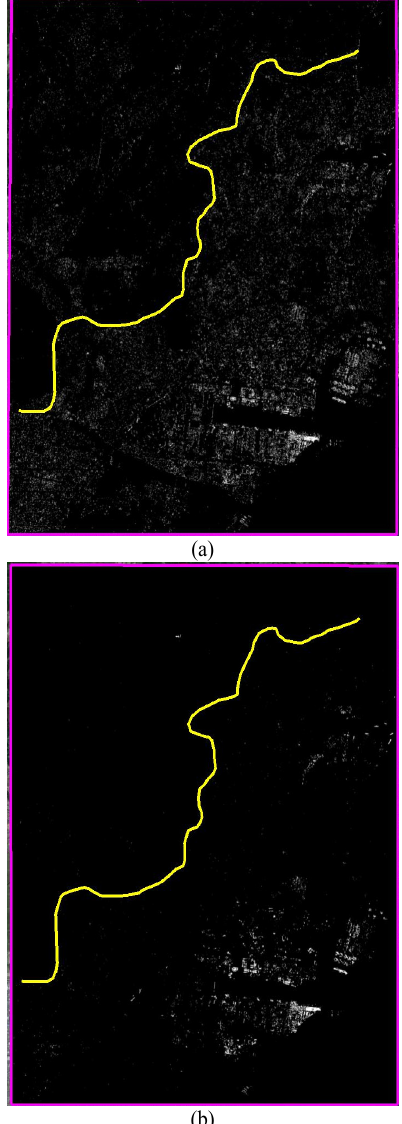
Figure 7. (a) The detected change areas (white), which are extracted by using thresholding from the difference image (Figure 6(a)) without Curvelet filtering. The specification of the yellow line is interpreted in the caption of Figure 5. (b) The detected change areas (white), which are extracted by the same way in (a) but from the difference image (Figure 6(b)) with Curvelet filtering.